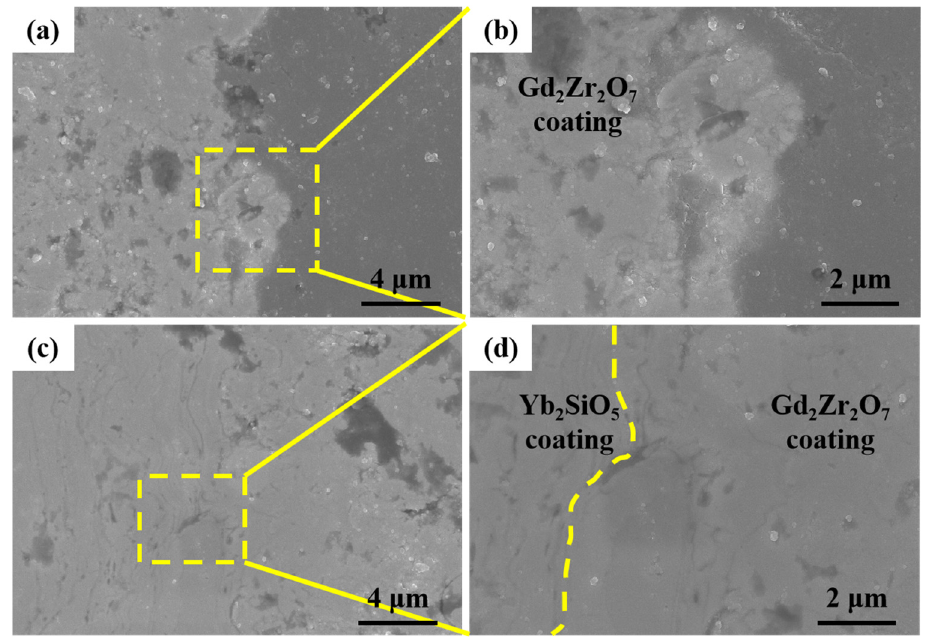
Figure 5. Cross-sectional micromorphology: ( a ) Gd 2 Zr 2 O 7 coatings; ( b ) enlargement of ( a ); ( c ) Gd 2 Zr 2 O 7 /Yb 2 SiO 5 interface; ( d ) enlargement of ( c ).